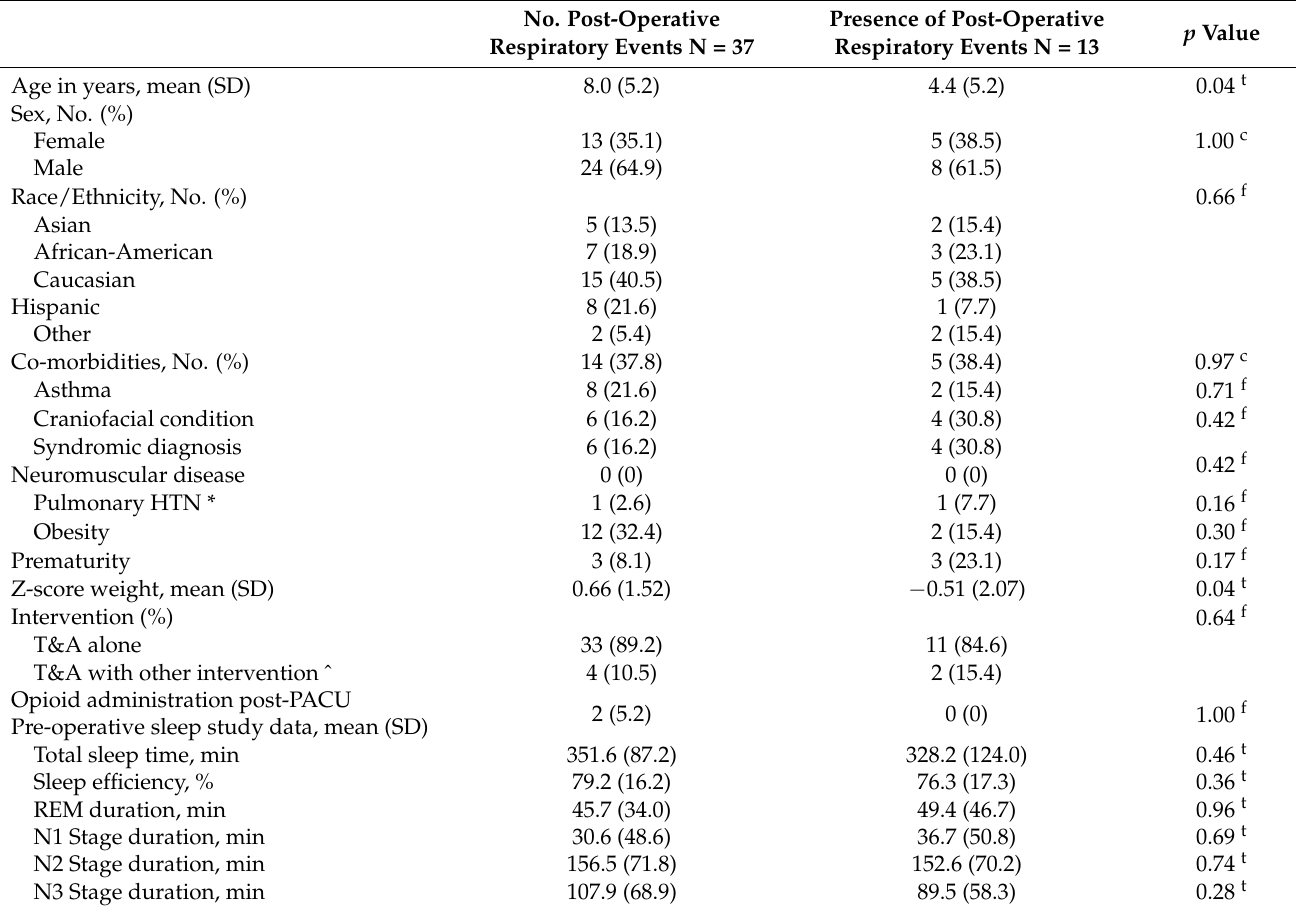
Table 2. Univariate analysis of baseline characteristics among children with pre-operative AHI ≥